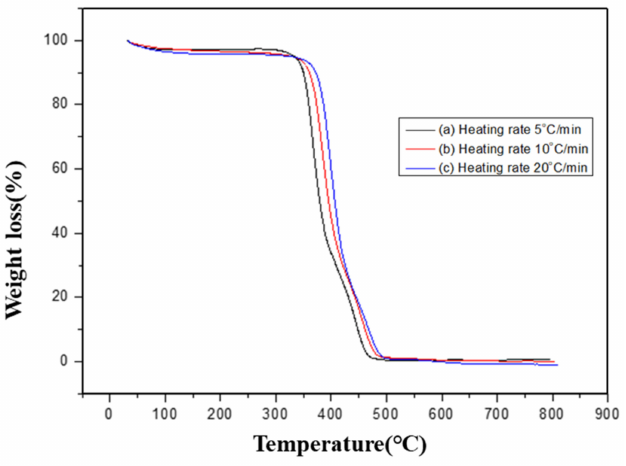
Figure 4. Thermogravimetric analysis (TGA) scans of the PBT–EVOH polymer composite film using 0.2% triallylamine crosslinking